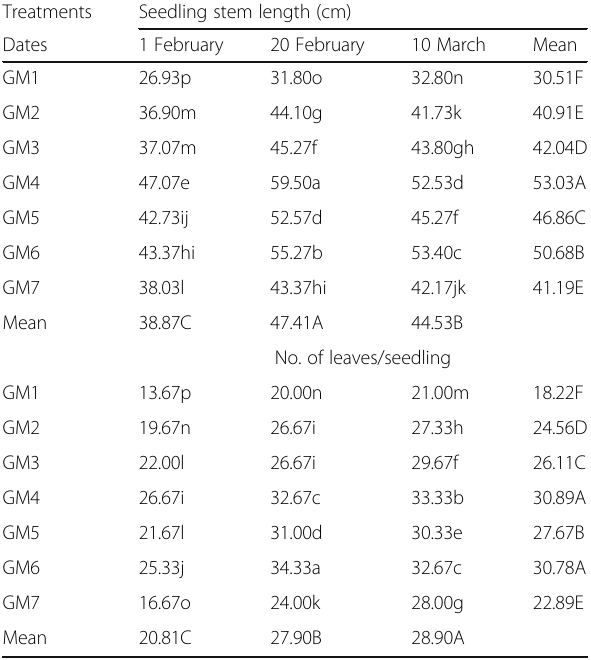
Table 3 Effect of planting dates and different growing media and the interactions between them on stem length and number of leaves/seedling of pistachio seedlings Treatments